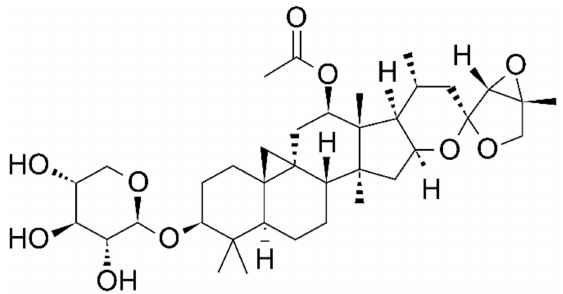
Figure 2. Chemical structure of 27 −